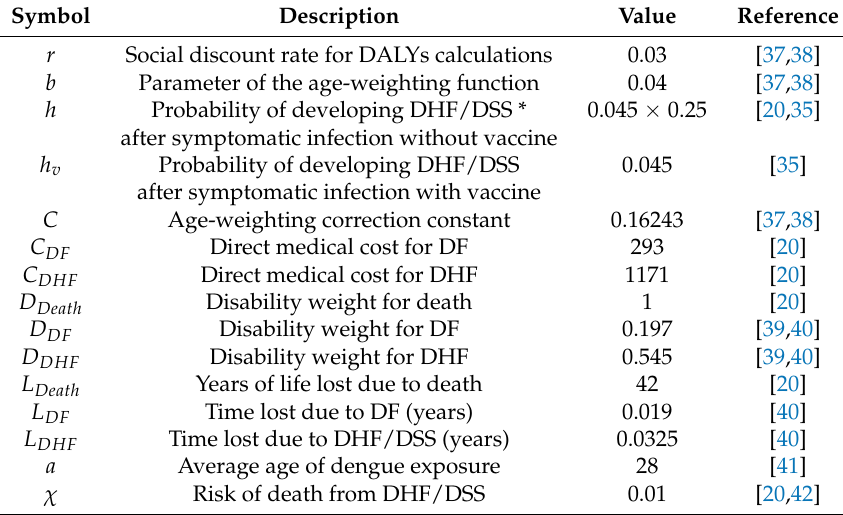
Table 3. Descriptions and values of parameters for